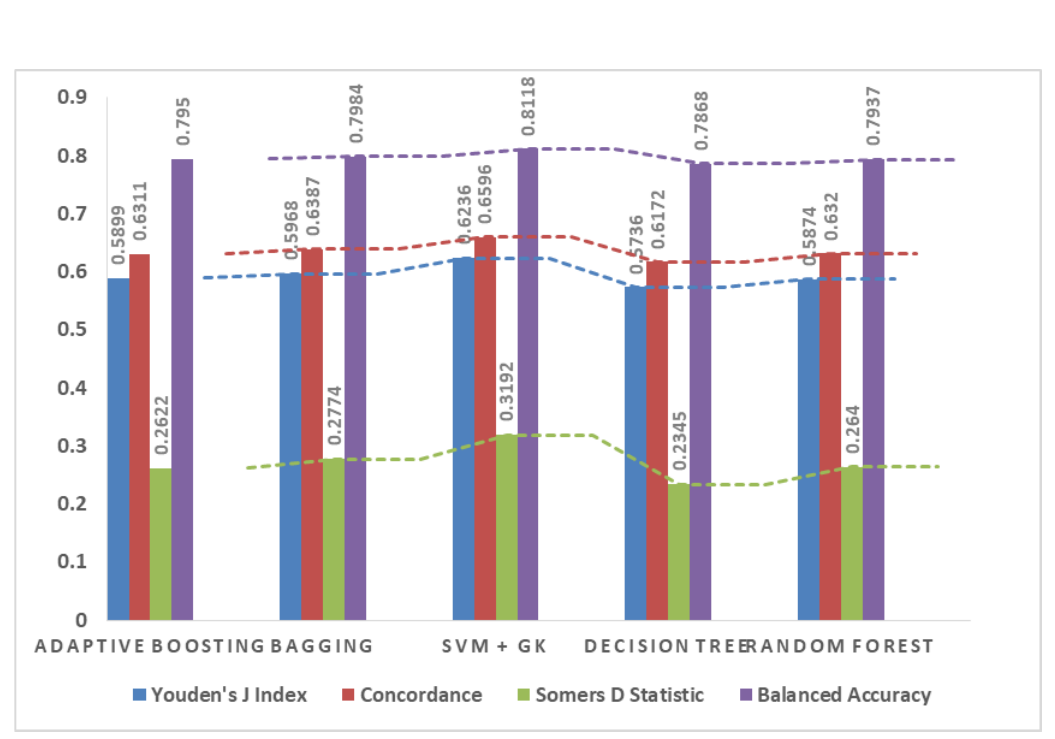
Figure 7. Comparing four evaluation metrics of all